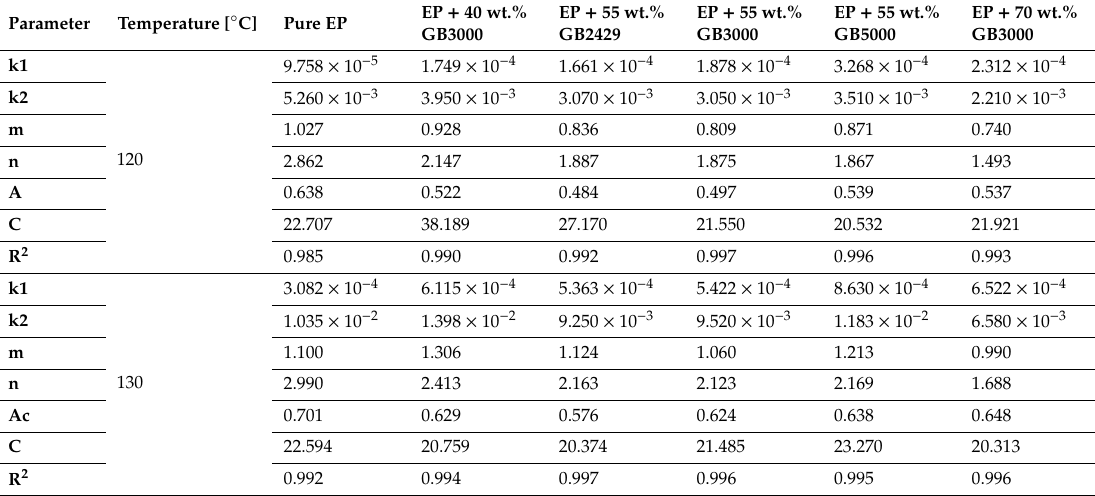
Figure 11. Measured curing speed in comparison to calculated speed with and without the diffusion factor at isothermal temperature ( a ) 120 °C and ( b ) 155 °C. Table 4. Parameters used in Kamal-Sourour’s model with di ff usion factor (Equation